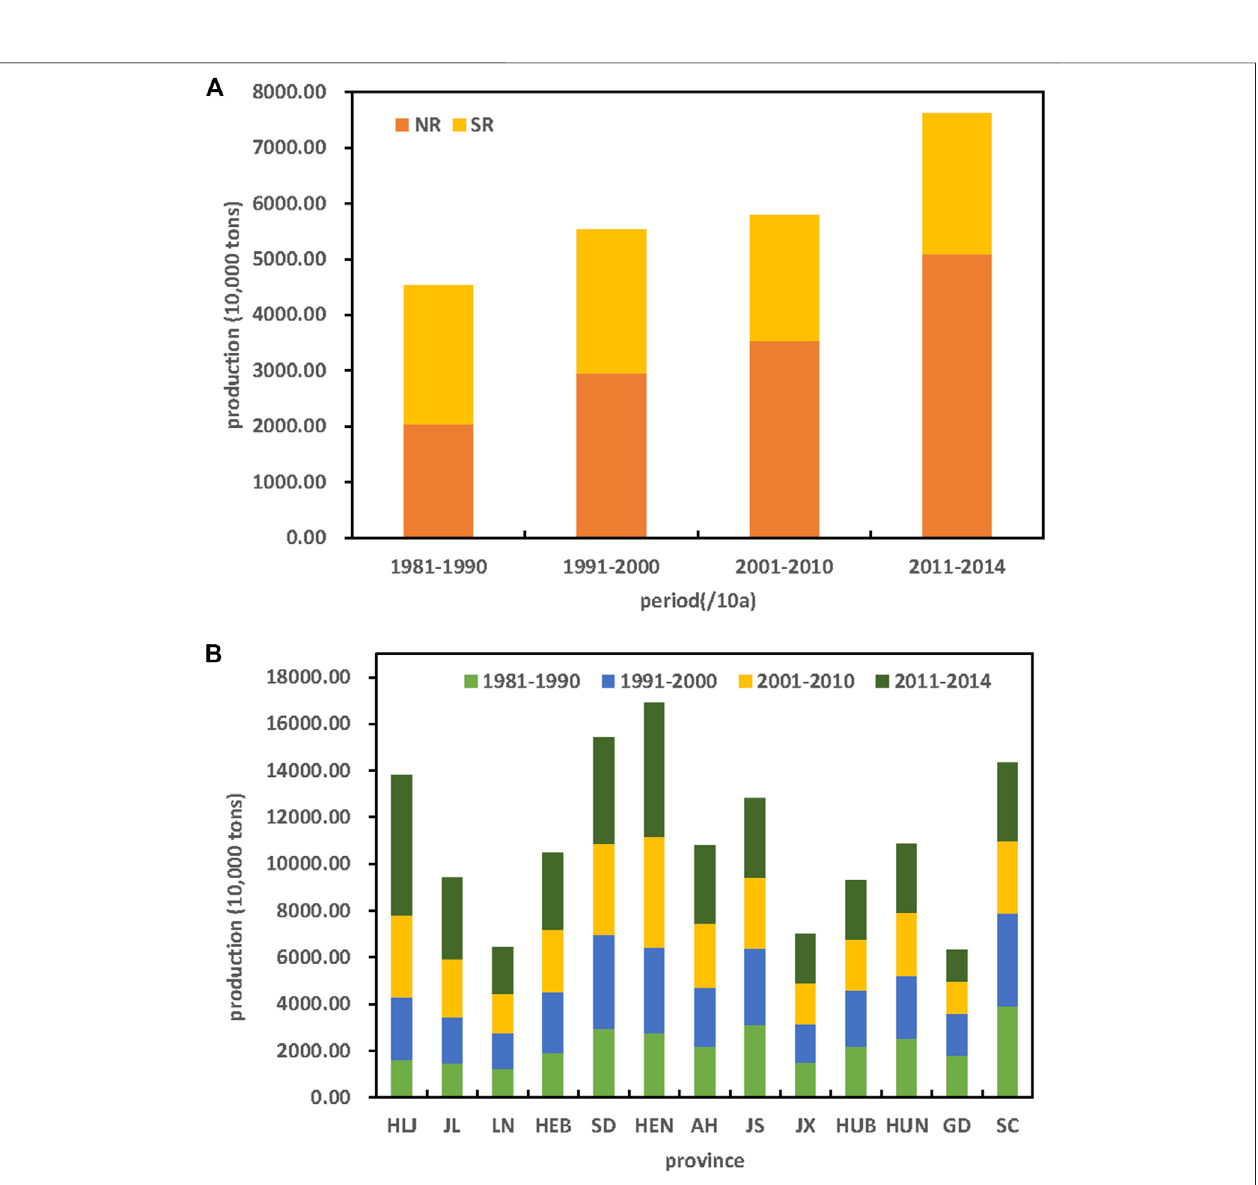
FIGURE 5 | The interdecadal changes in the grain production in the China ’ s main grain-producing areas. (A) , the interdecadal grain production changes in the North and South regions from 1981 to 2014. (B) , the interdecadal changes in grain production in 13 provinces from 1981 to 2014, the fi rst six provinces belong to the North region, and the last seven provinces belong to the South region. The North region (NR) includes Heilongjiang (HeiLJ), Jilin (JiL), Liaoning (LiaoN), Hebei (HeB), Shandong (ShanD) and Henan (HeN) Provinces. The South region (SR) includes Anhui (AnH), Jiangsu (JiangS), Jiangxi (JiangX), Hubei (HuB), Hunan (HuN), Guangdong (GuangD) and Sichuan (SiC)